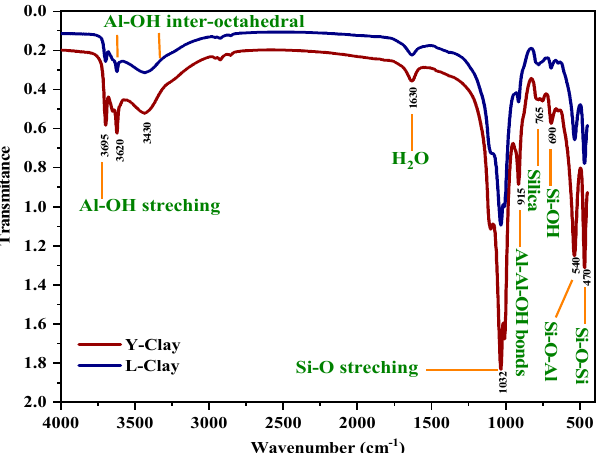
Figure 1. FTIR spectra of Y-Clay and L-Clay.